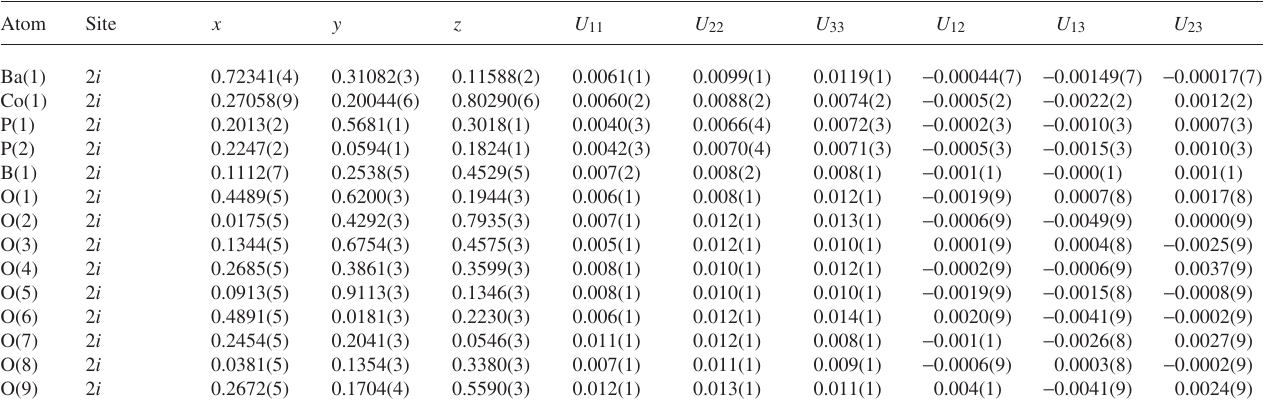
Table 3. Atomic coordinates and displacement parameters (in Å 2 ) .